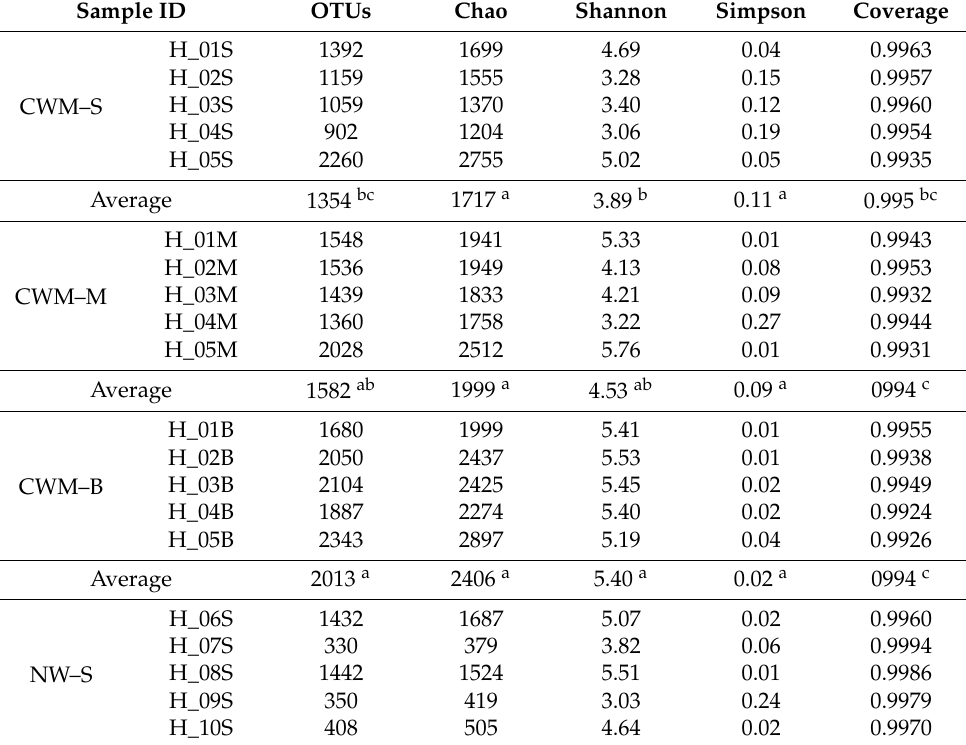
Table 1. Characterization of plankton richness and diversity indices in different waters of the South Yellow